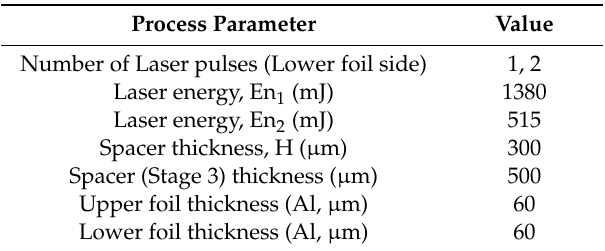
Table 5. Number of laser pulses on the lower foil side and other experimental process